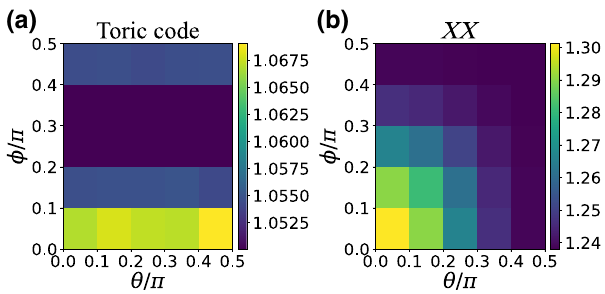
FIG. 9. The scaling factor ξ 1 of the normalized variance of the first moment with system size as defined in Eq. (33), as a function of the working basis defined by φ , θ ∈ [0, 2 π) in Eq. (55) for the partial-basis distribution, Eq. (29), and for (a) the toric code ground state for a checkerboard partition and (b) the XX model ground